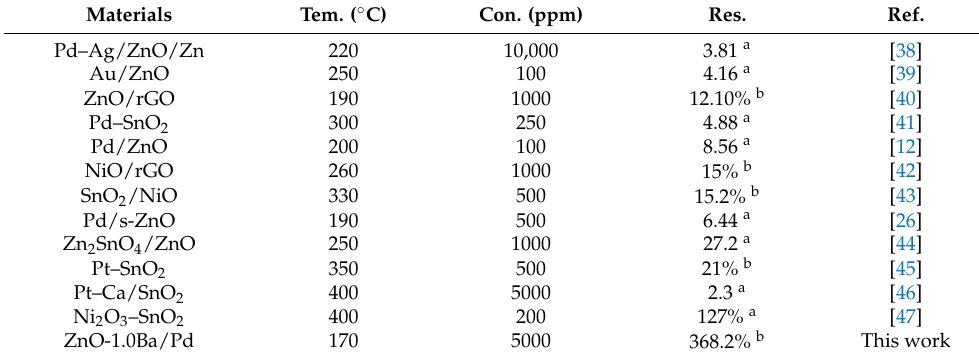
Figure 5. ( a ) The Pd 3d XPS spectra of the different samples; ( b ) reproducibility of ZnO/Pd, ZnO- 0.5Ba/Pd, ZnO-1.0Ba/Pd, ZnO-1.5Ba/Pd, and ZnO-2.0Ba/Pd; ( c ) selectivity of ZnO-1.0Ba/Pd at the working temperature of 170 ◦ C; ( d ) stability tests for five ZnO-based sensors. Table 1. The sensing performance of the CH 4 sensor in this work in comparison to previous